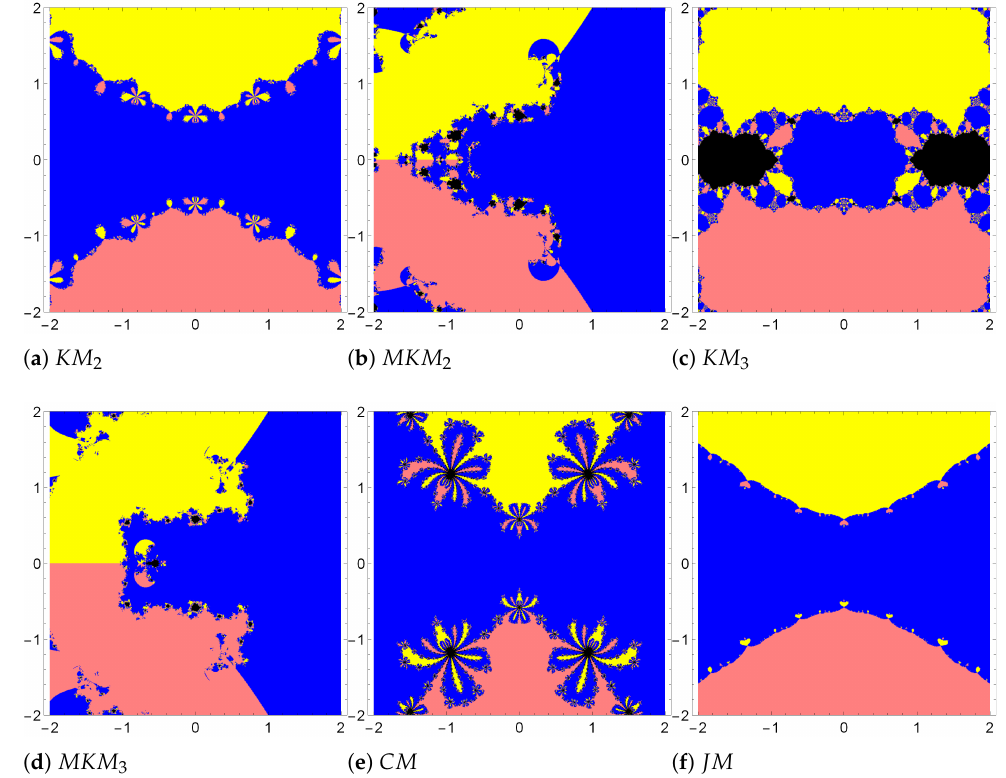
Figure 5. Dynamical planes of new and existing methods for Example